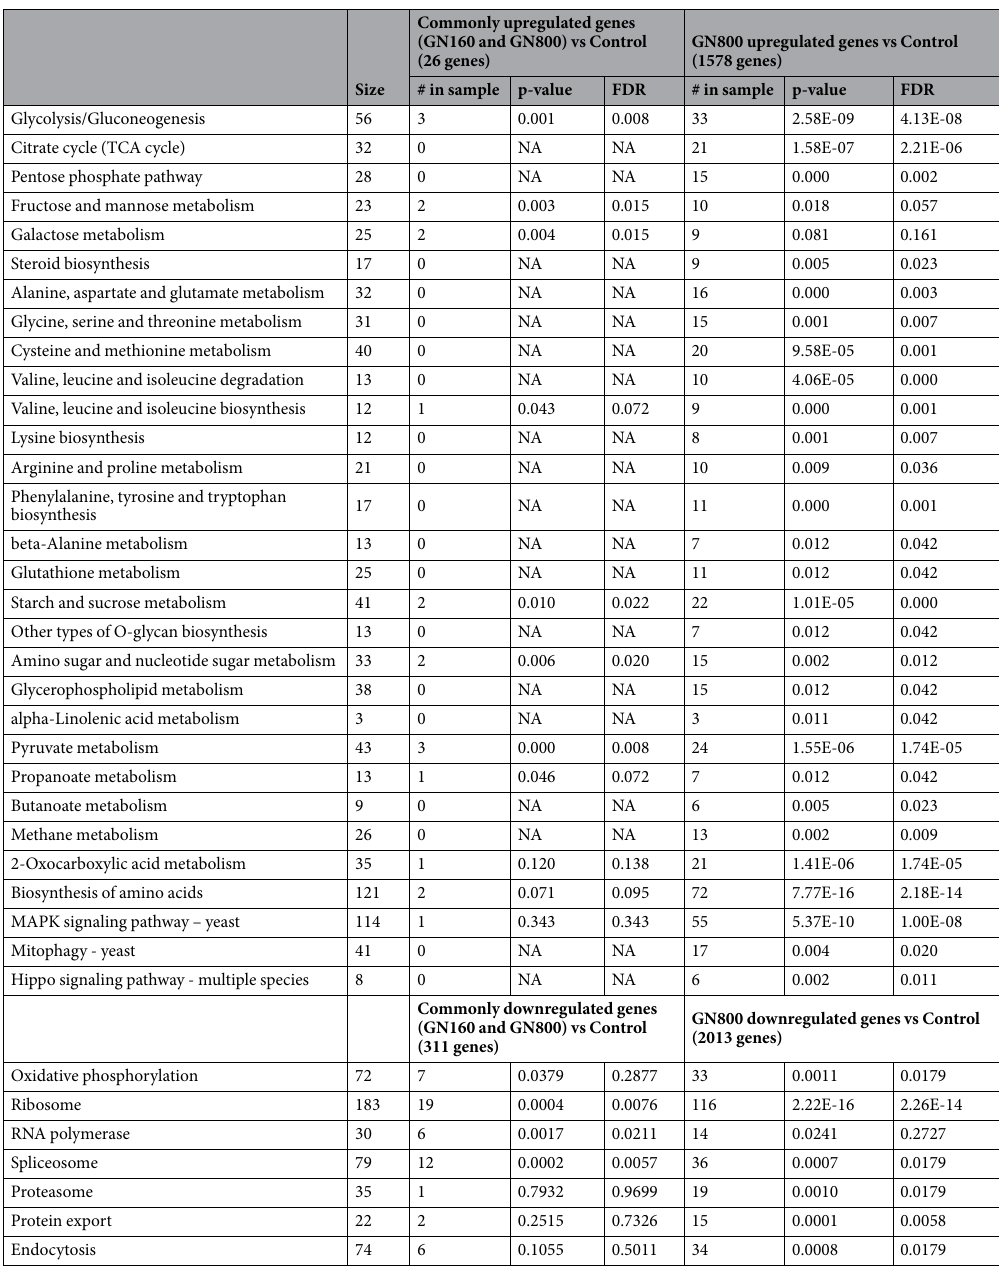
Table 2. Metabolic pathway enrichment analysis. Size indicates number of genes in the genome assigned to the pathway, whereas #in sample refer to the considered set. Only pathways with FDR < 0.05 in some of the sets have been kept. NA indicates not